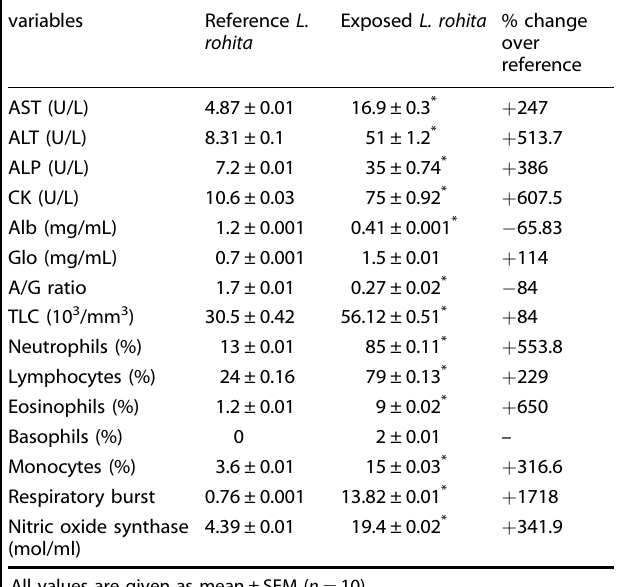
Table 4. TLC is the most valued character to check the host ’ s